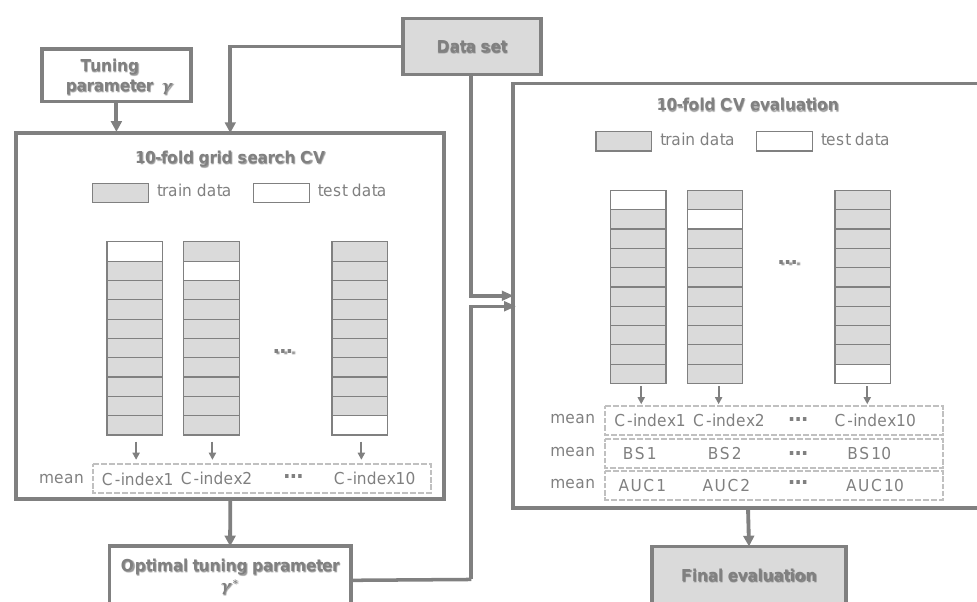
Figure 3. A flowchart of the 10-fold CV procedure of the DNNSurv model. Table 2. The hyperparameter settings in the DNNSurv model for each type of covariate in the three datasets. Type of